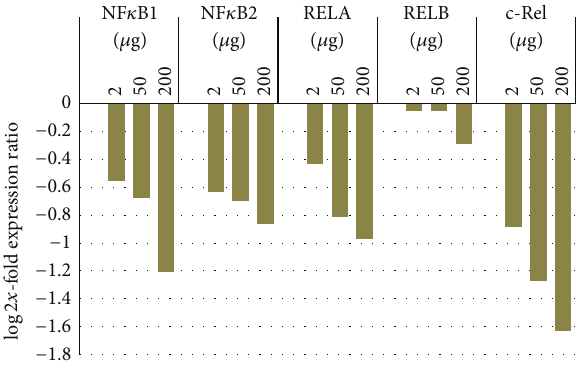
Figure 5: Changes in the expression levels of five NF- 𝜅 B subunits, NFKB1 (nuclear factor kappa B1), NFKB2 (nuclear factor kappa B2), RELA(v-relavianreticuloendotheliosisviraloncogenehomologA), RELB (v-rel avian reticuloendotheliosis viral oncogene homolog B), and c-Rel (cellular counterpart of the v-Rel oncogene) in breast cancer MCF-7 cells treated with increasing concentrations (2 𝜇 g, 50 𝜇 g, and 200 𝜇 g) of sponge extract compared to those of untreated